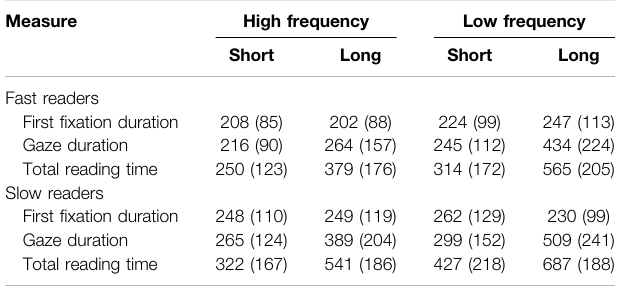
TABLE 2 | Mean fi xation measures (in milliseconds) on the target words for word frequency and length in both groups (standard deviations in parentheses). Measure